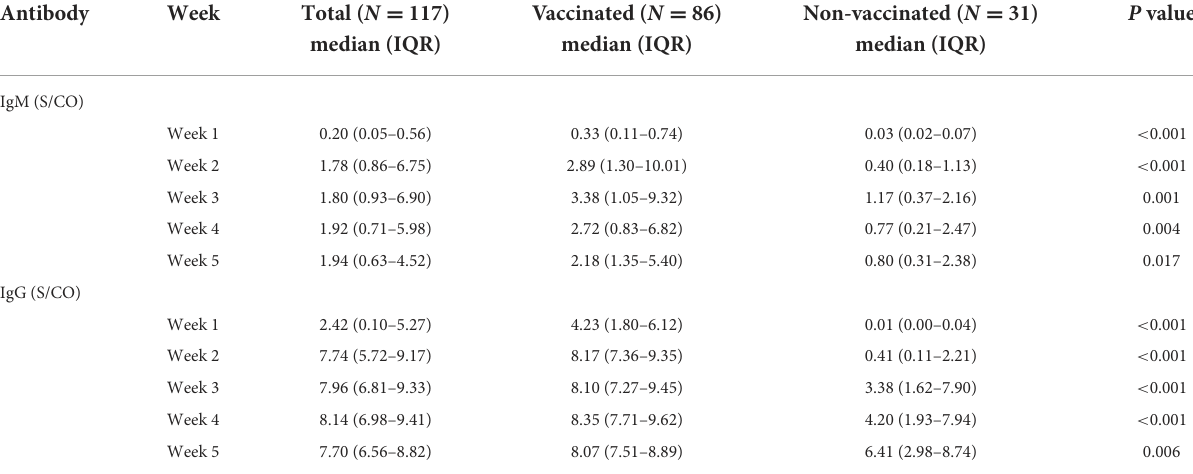
TABLE 2 Antibody values in the course of disease after diagnosis during the outbreak.